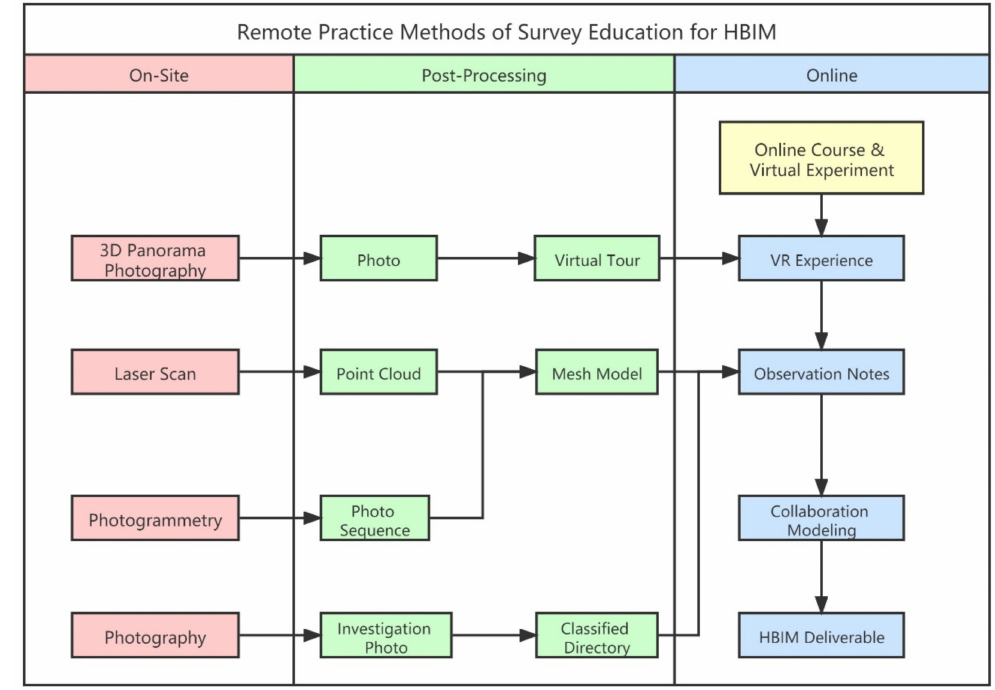
Figure 23. The procedure of remote practice methods of survey education for